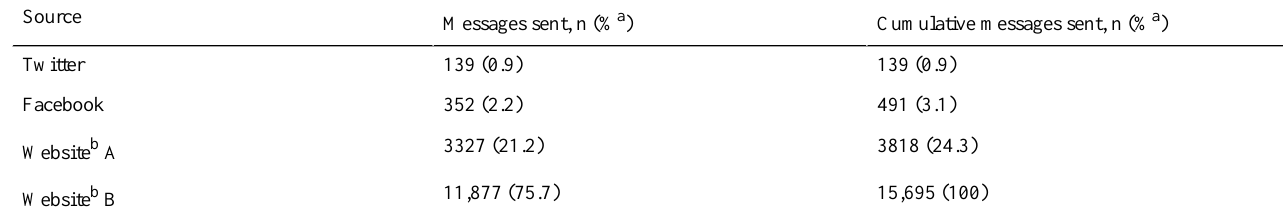
Table 2. Messages sent across social media platforms by